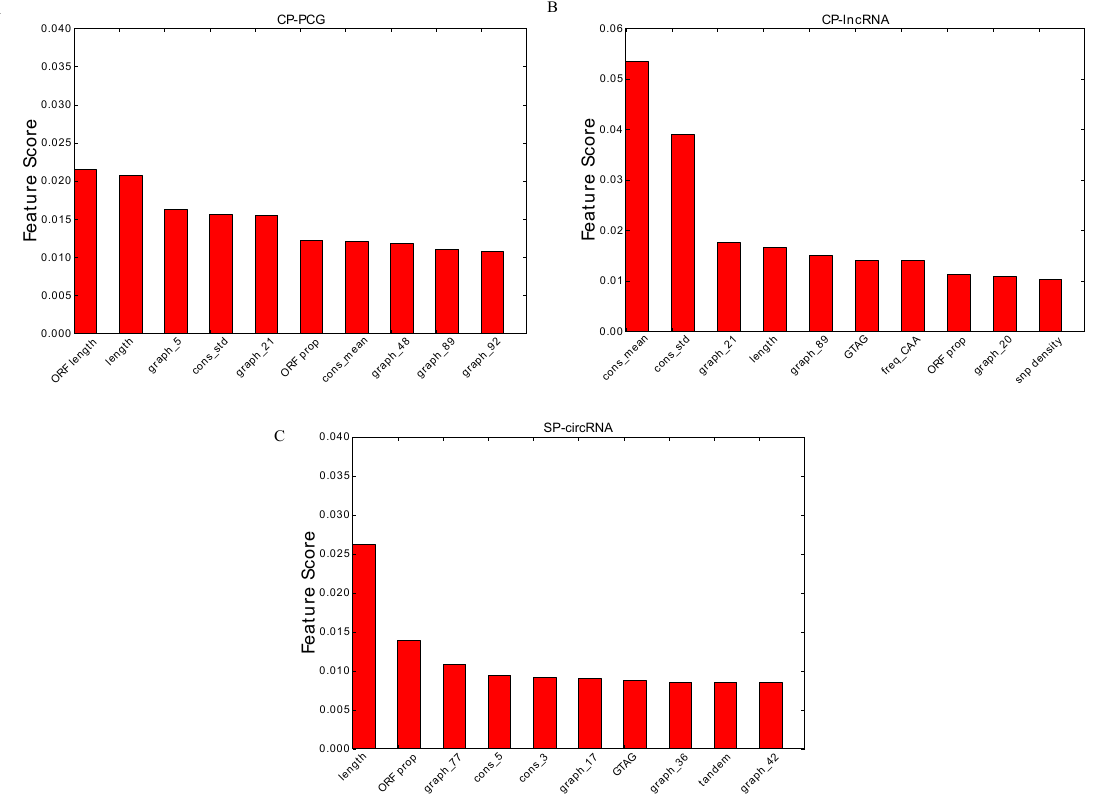
Figure 5. The Top 10 features for: ( A ) the CP-PCG model; ( B ) the CP-lncRNA model; and ( C ) the SP-circRNA model. Prefix graph refers to the 101 graph features, prefix cons refers to conservation feature and prefix freq refers to codon frequency